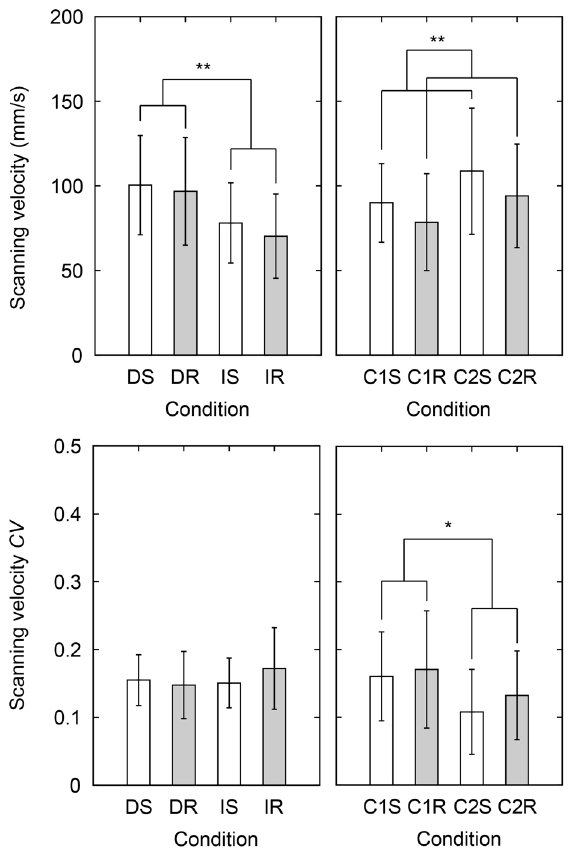
Figure 7. Averages and coefficients of variation of normal force in the various conditions. Left panels: DS, DR, IS, and IR and right panels: C1S, C1R, C2S, and C2R indicate each condition. D, I, C1, and C2 mean discrimination task, identification task, 1 st control condition, and 2 nd control condition, and S and R mean smooth group and rough group. Error bars indicate the standard deviation. *indicates p , 0.05 and ** p , 0.01 with Wilcoxon signed rank tests.